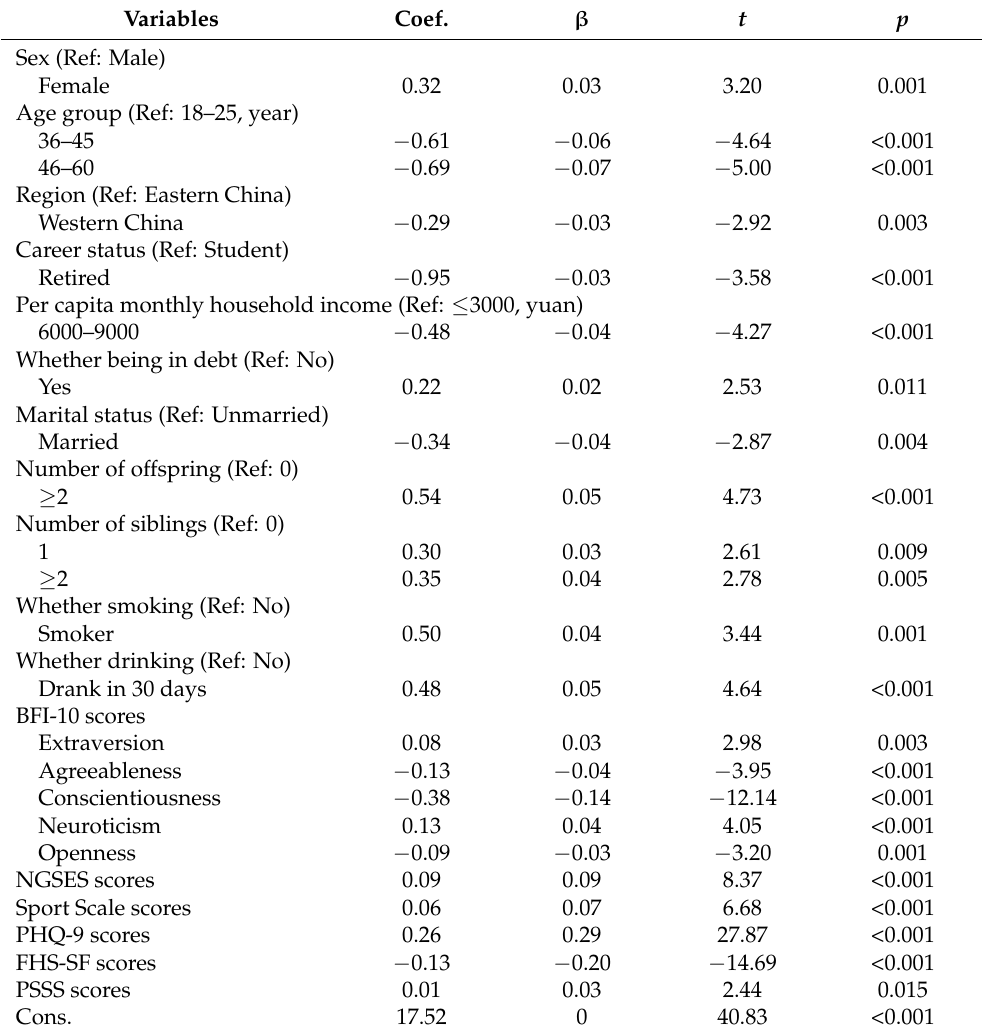
Table 3. The stepwise regression analysis of factors associated with EBS-SF